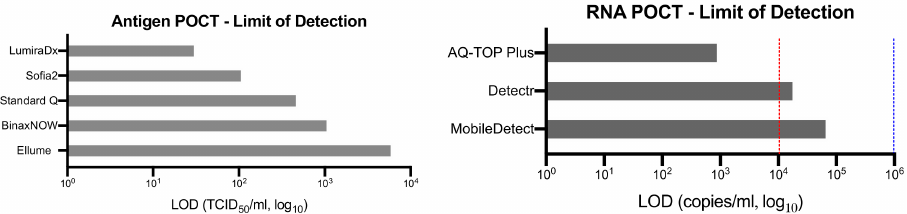
Figure 3. Analytical Sensitivity (limit of detection) of selected POCTs. Limit of detection (LOD) of SARS-CoV-2 antigen POCTs ( left panel ) and RNA POCTs ( right panel ), as reporter in manufacturer’s instruction for use (IFU). Blue and red lines represent WHO TPP “acceptable” and “desirable” LOD thresholds, respectively. The LOD thresholds are not available for TCID 50 / mL